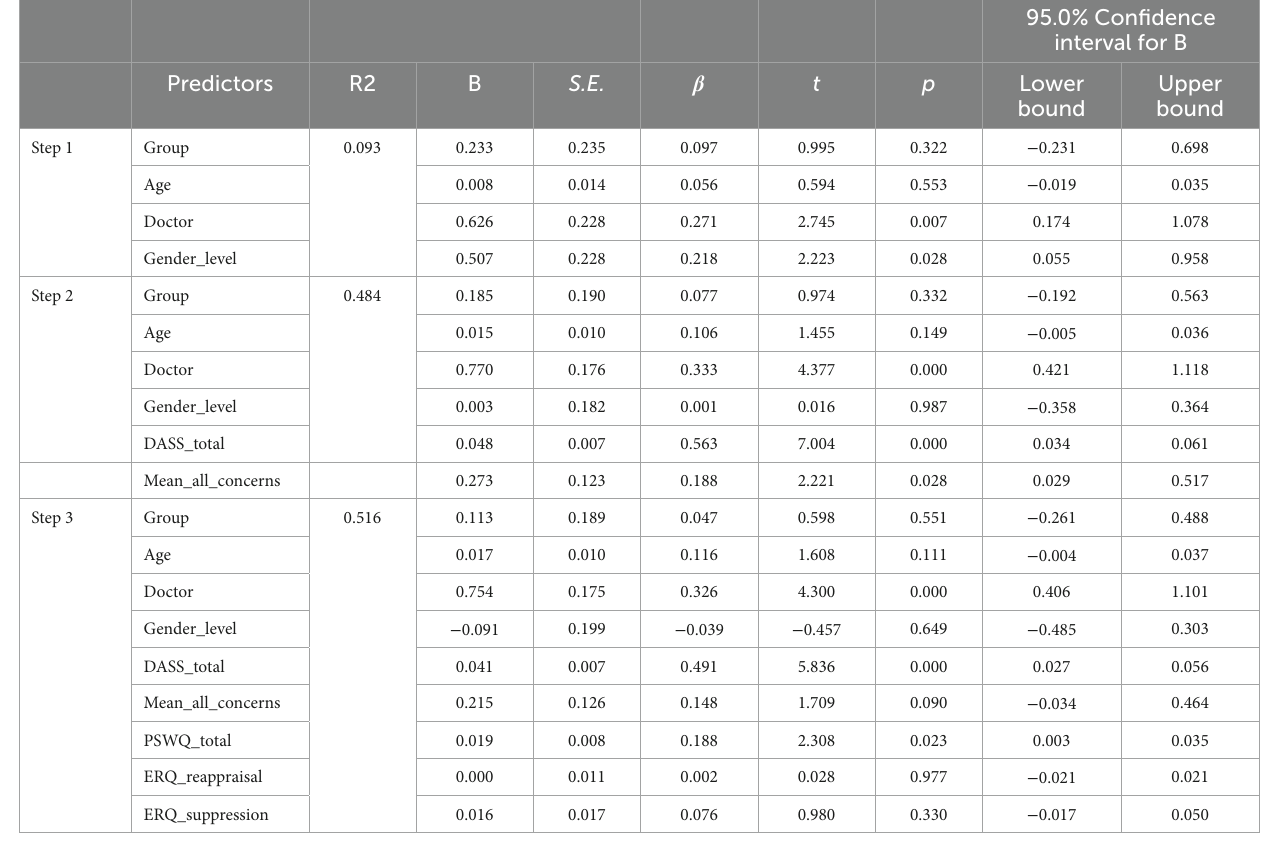
TABLE 3 Predictors of job burnout.